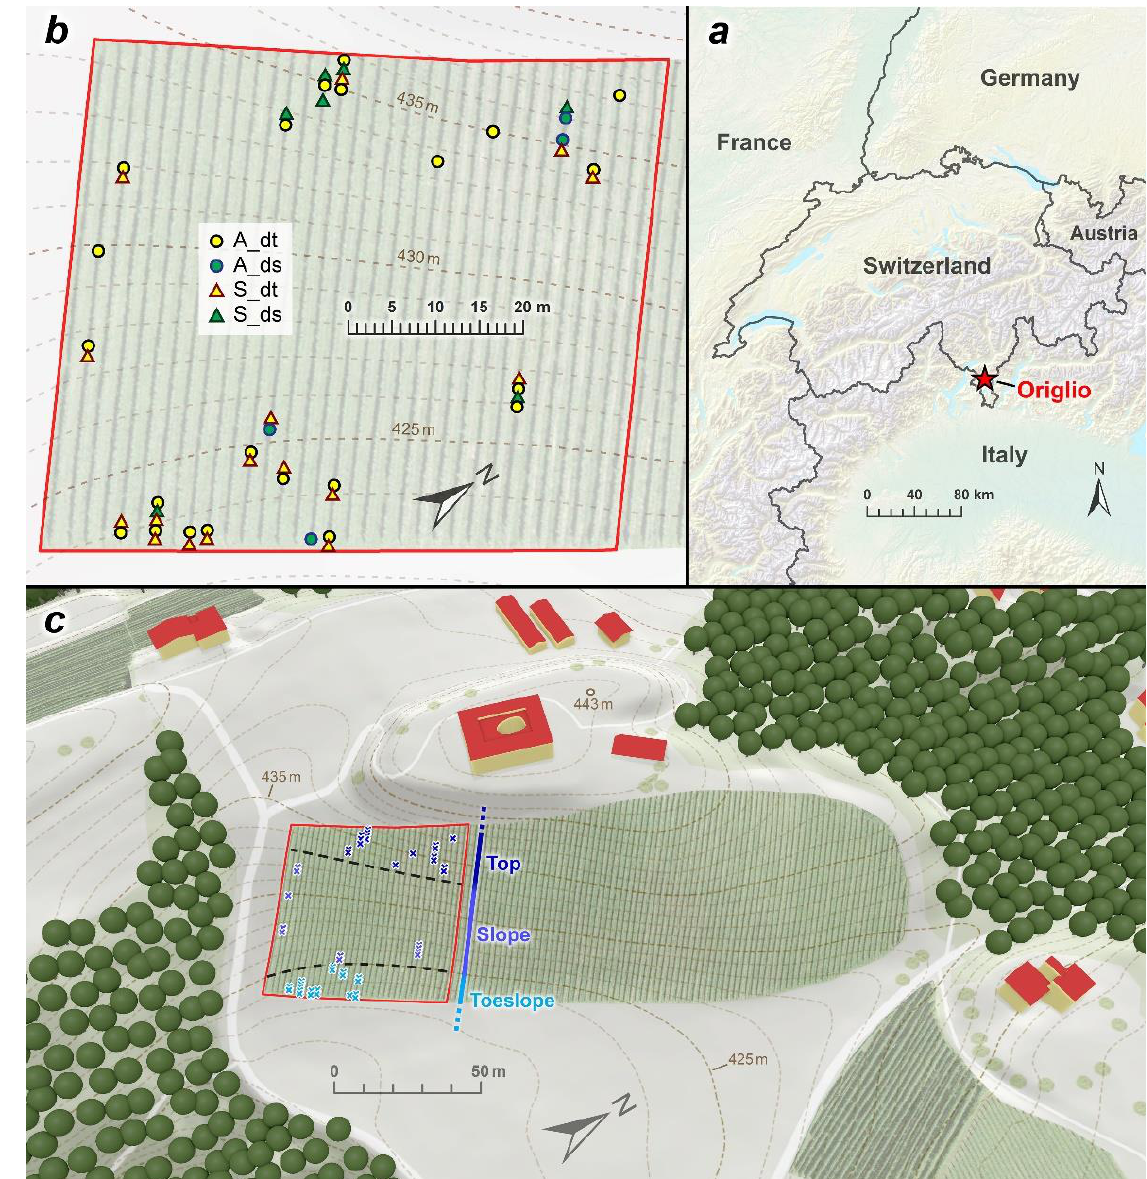
Figure 1. Study area and distribution of the sampled grapevines. ( a ) location of the vineyard; ( b ) detailed map of the sampled individuals; ( c ) geomorphological slope gradient within the vineyard. A_dt = Asymptomatic and drought-tolerant; A_ds = Asymptomatic and drought-sensitive; S_dt = Symptomatic and drought-tolerant; S_ds = Symptomatic and drought-sensitive.